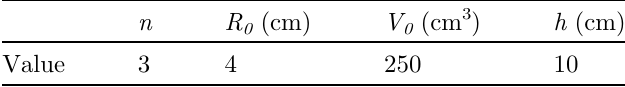
Table 5. Geometric parameters of air spring.